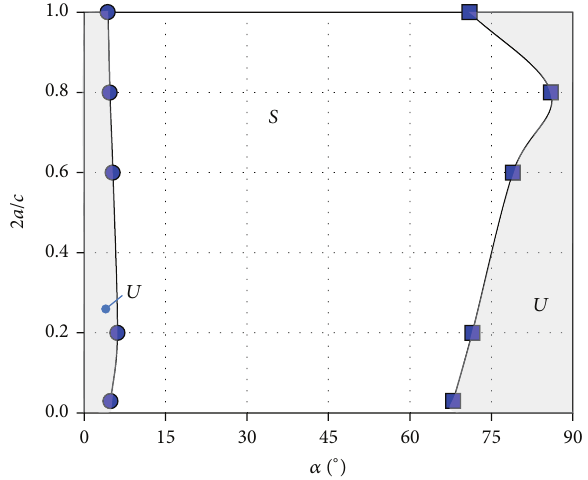
Figure 7: Stability diagram of H beams in the porosity versus angle ofattackplane( 𝜙 versus 𝛼 plane).TheresultscorrespondtoHbeams with 2𝑎/𝑐 = 0.03 and 𝑐/𝑏 = 2 , where the lengths 𝑎 , 𝑏 , and 𝑐 are defined in Figure 2. Shadowed areas indicate unstable regions, althoughtherighthandsideregionisonlymarginallyunstable.Note that, for large values of the porosity, H beams are not unstable. Red symbols correspond to dynamic test results (see Section